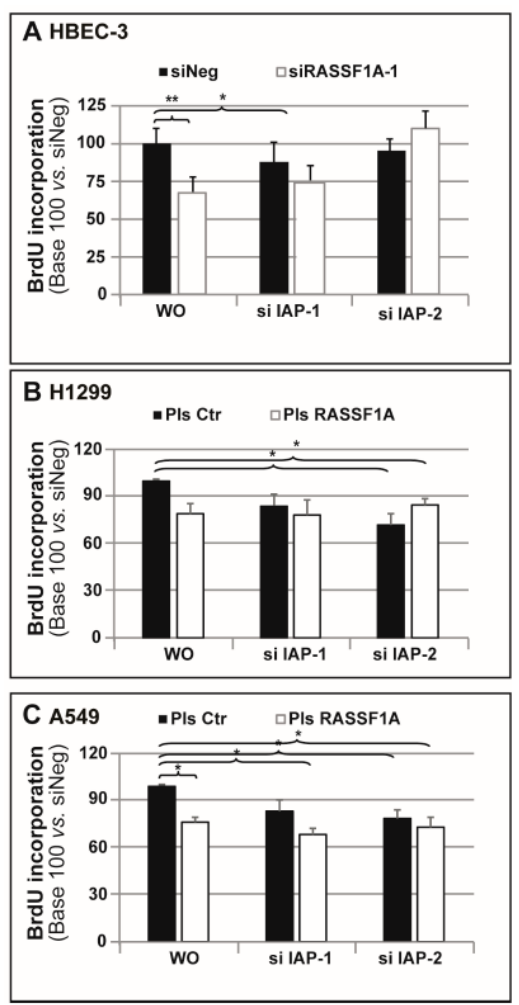
Figure 4. IAP-2 interferes with RASSF1A-mediated cell proliferation. HBEC-3 cells were transiently transfected with siNeg and siRASSF1A-1, whereas A549 and H1299 cells were transfected with plasmid coding wild-type RASSF1A . ( A–C ) Cell proliferation was assessed using BrdU incorporation and subsequent spectrophotometric detection at 450 nm wavelength in ( A ) HBEC-3, ( B ) H1299, and ( C ) A549. The data are expressed as the mean ± SEM from three individual experiments. The statistical significance was determined using a Student’s t -test. * p < 0.05; ** p < 0.01.